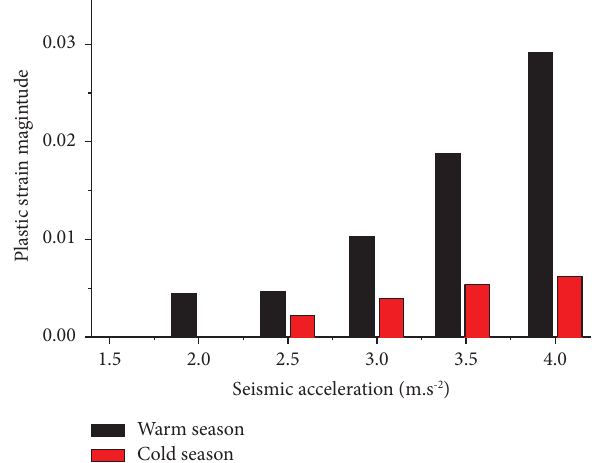
Figure 13: Te variation of maximum plastic strain with the input ground motion acceleration